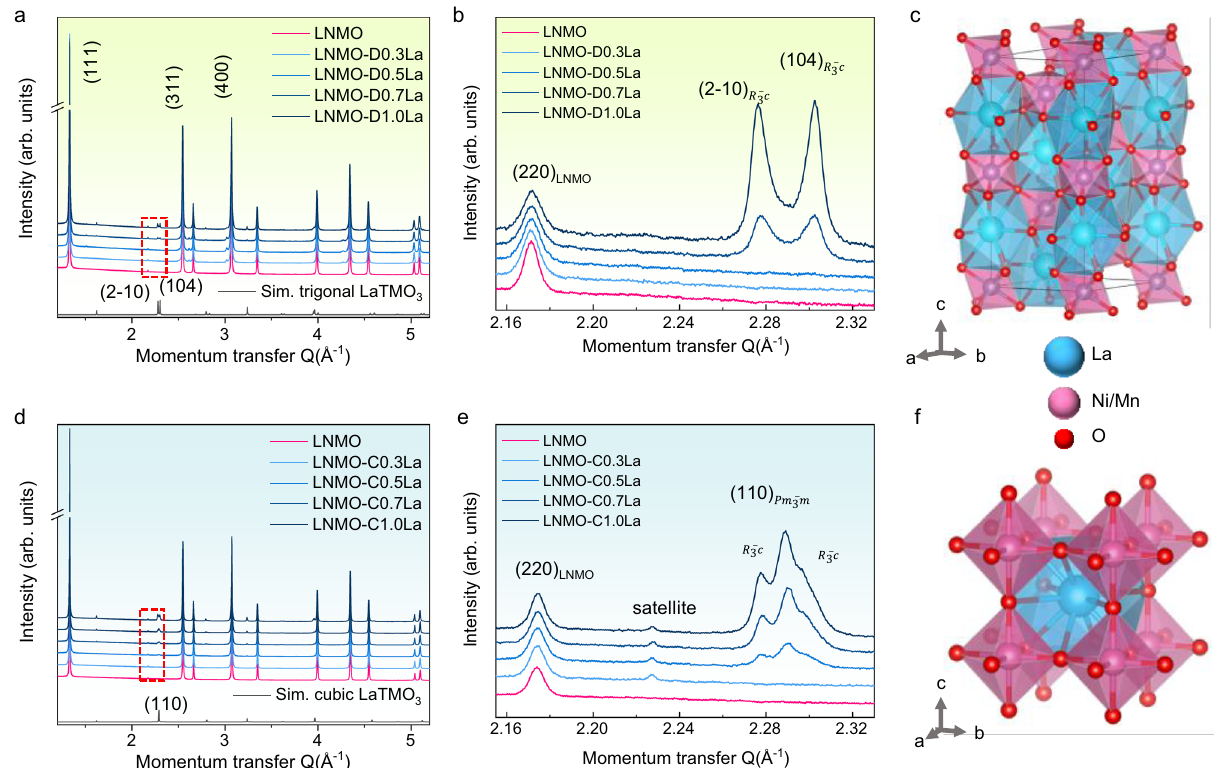
Fig. 2 Phase analysis of the LNMO samples modi fi ed by La. a Synchrotron XRD data of pristine and La doped LNMOs. b Zoom of the dashed red frame in ( a ) showing the characteristic LaTMO 3 peaks in doped samples. c The structure model of rhombohedral LaTMO 3 . d Synchrotron XRD data of pristine and La coated LNMOs. e Zoom of the dashed red frame in d indicating the characteristic LaTMO 3 peaks in coated samples. f The structure model of cubic LaTMO 3